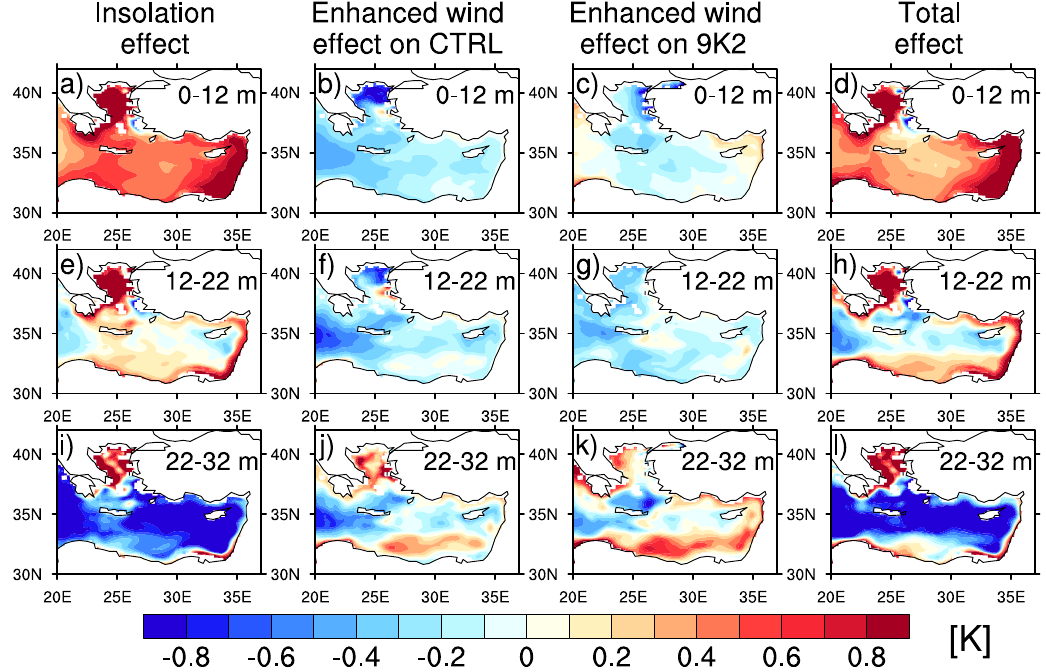
Fig. 17. Anomalies of temperature for different model depth layers for summer (JAS). The columns show the isolated effect of insolation forcing (9K2-W0 vs. CTRL), enhanced Etesian winds on CTRL climate (CTRL-W9 vs. CTRL) and on 9K2 climate (9K2 vs. 9K2-W0), as well as the total effect of both factors (9K2 vs.